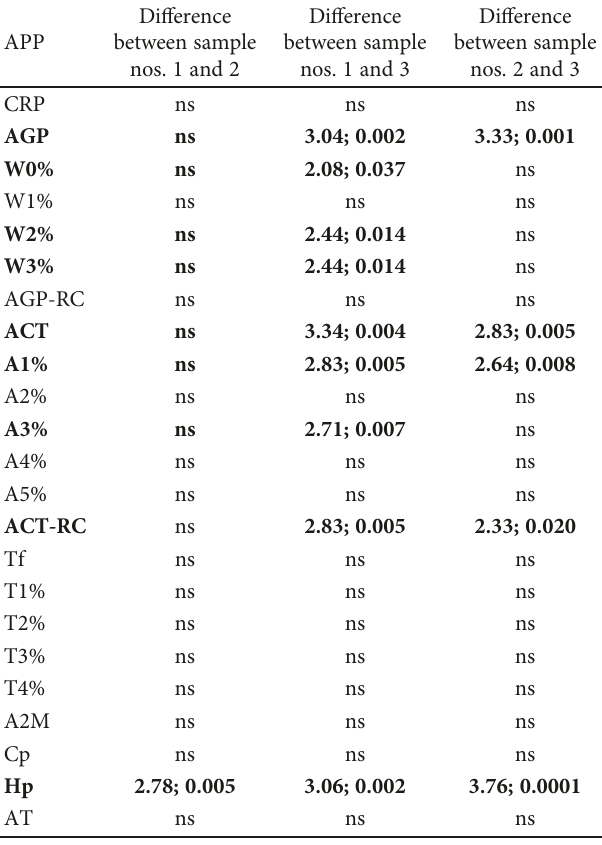
Table 3: Results of the statistical comparison of the results obtained at three time points (sample nos. 1, 2, and 3) investigated with the use of the Wilcoxon test for related variables (statistically signi fi cant di ff erences are marked in bold; the Z test value and p value are given; ns — not signi fi